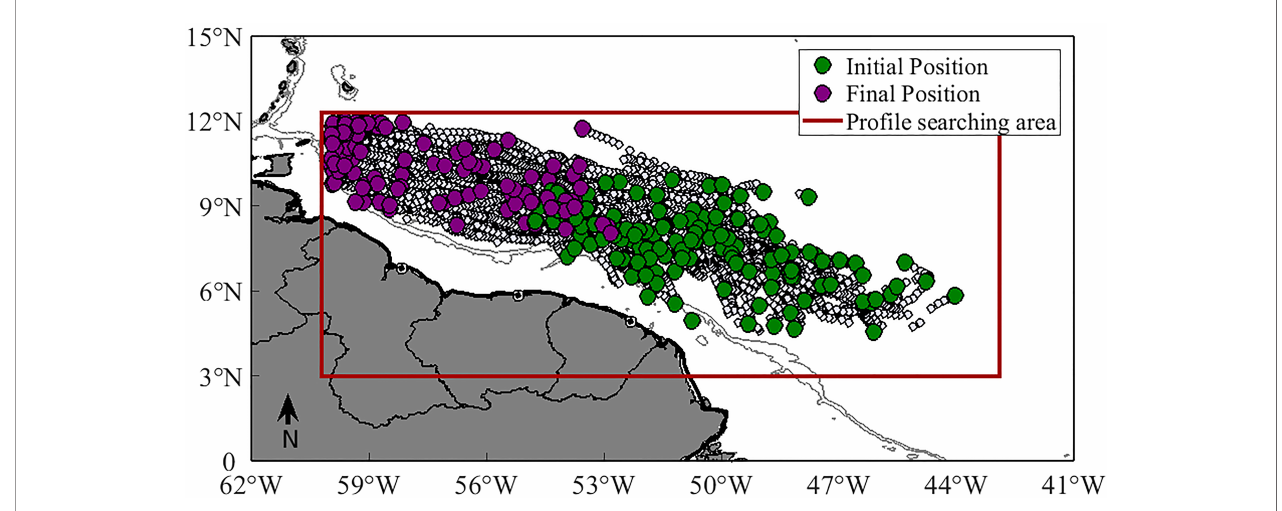
FIGURE 5 | The trajectory of the 128 NBC rings identi fi ed in the META dataset (white dots), between 1993 and 2016. Green dots indicate their initial position, and purple dots their fi nal position within the searching area (de fi ned by the red retangle). The gray lines are the 200 and 1000 m